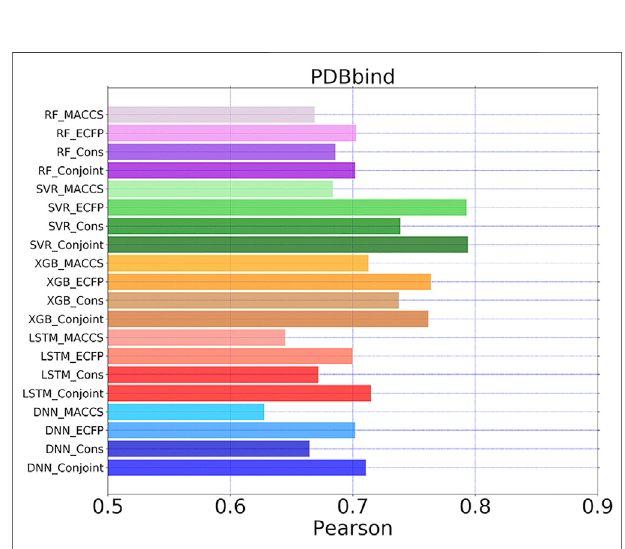
FIGURE 9 | Pearson coef fi cients for PDBbind dataset calculated by fi ve learning algorithms using MACCS keys, ECFP, consensus model and the conjoint fi ngerprints. The similar set of color represents one learning algorithm using different molecular fi ngerprints.